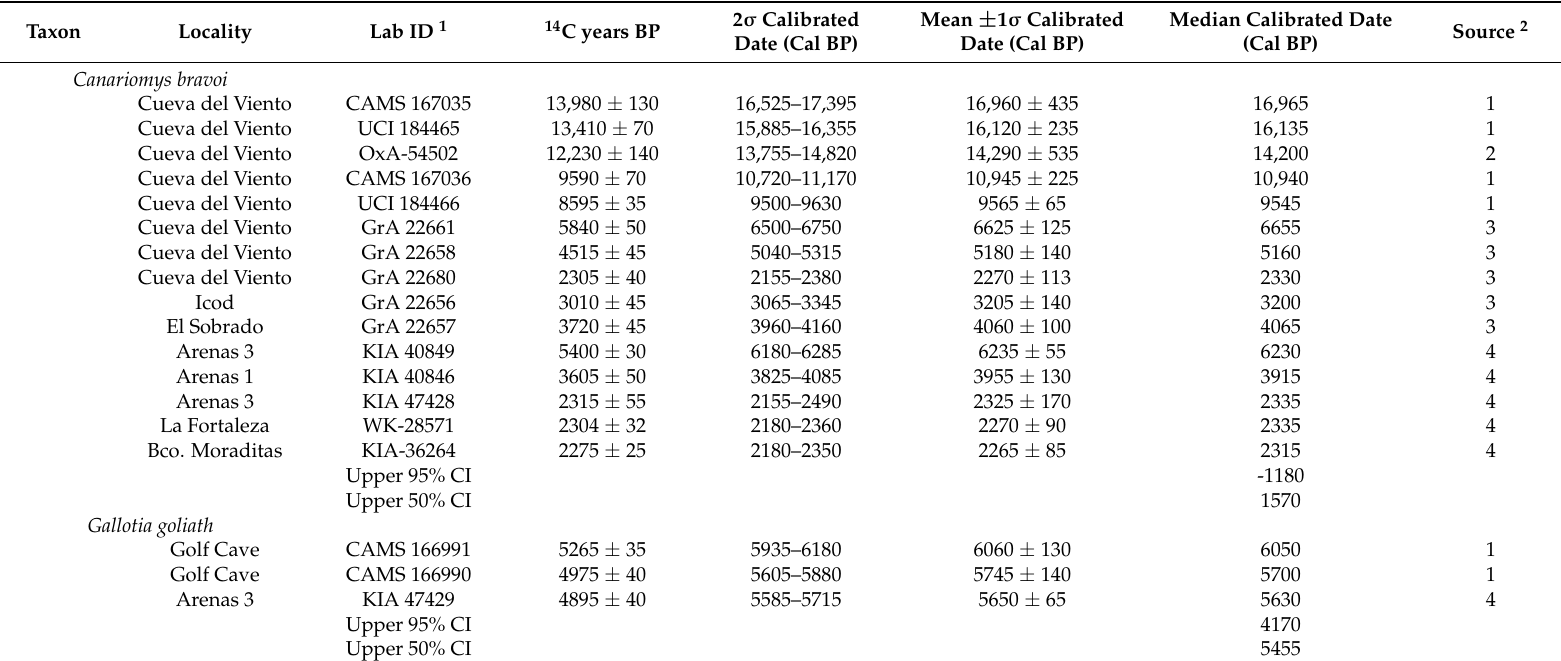
Table 2. Radiocarbon dates for giant rats and lizards on Tenerife. All calibrated ages were rounded to the nearest five